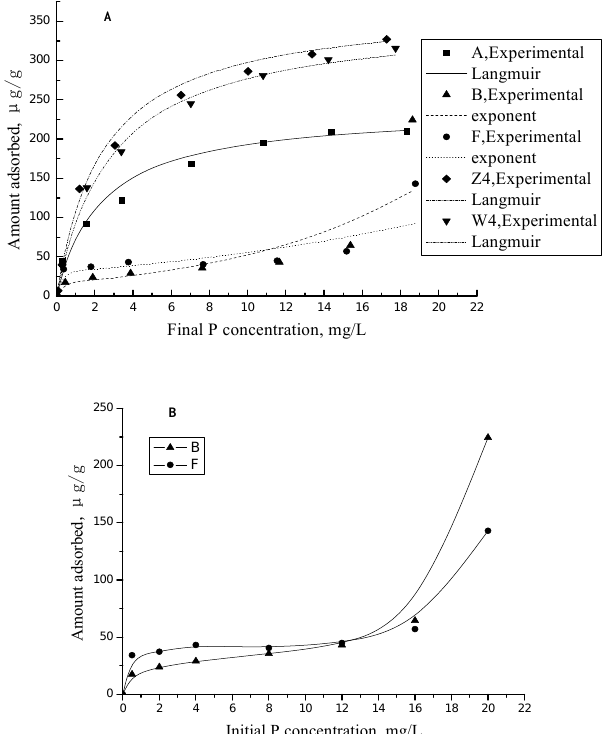
Fig. 2. (a) Adsorption isotherms of different sediments; (b) Ad- sorption capacity vs. initial liquid-phase phosphate concentrations Figure 2 (A) Adsorption isotherms of different sediments; (B) Adsorption capacity versus initial of samples B and liquid-phase phosphate concentrations of samples B and F.